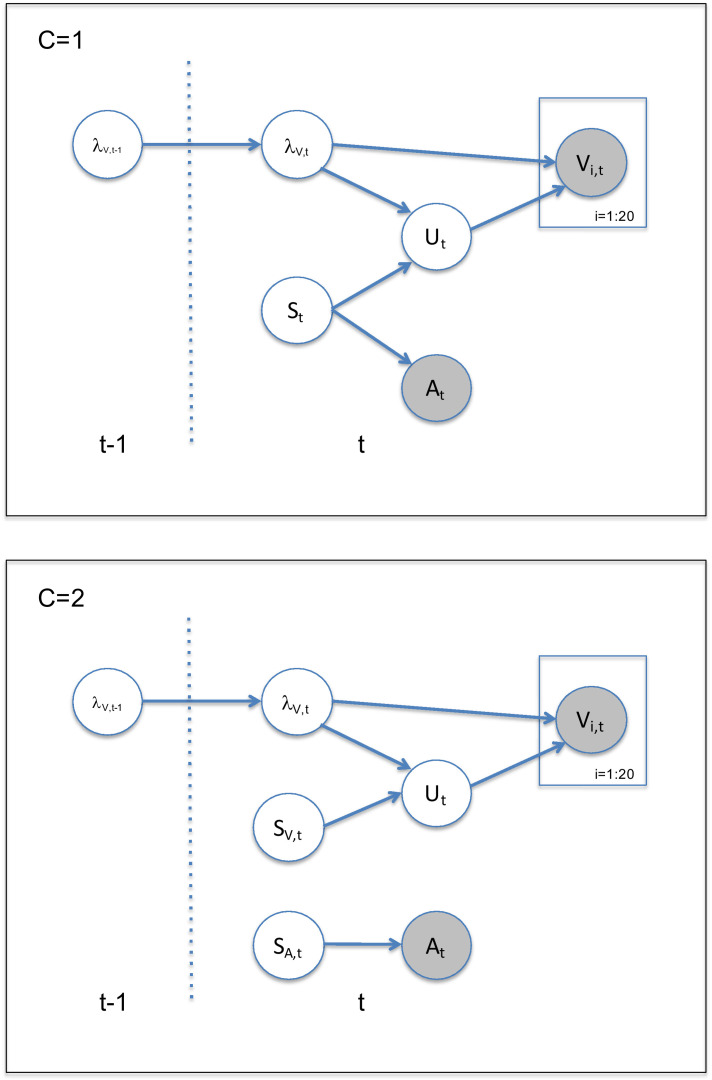
Generative model, for one (C = 1) or two sources (C = 2).